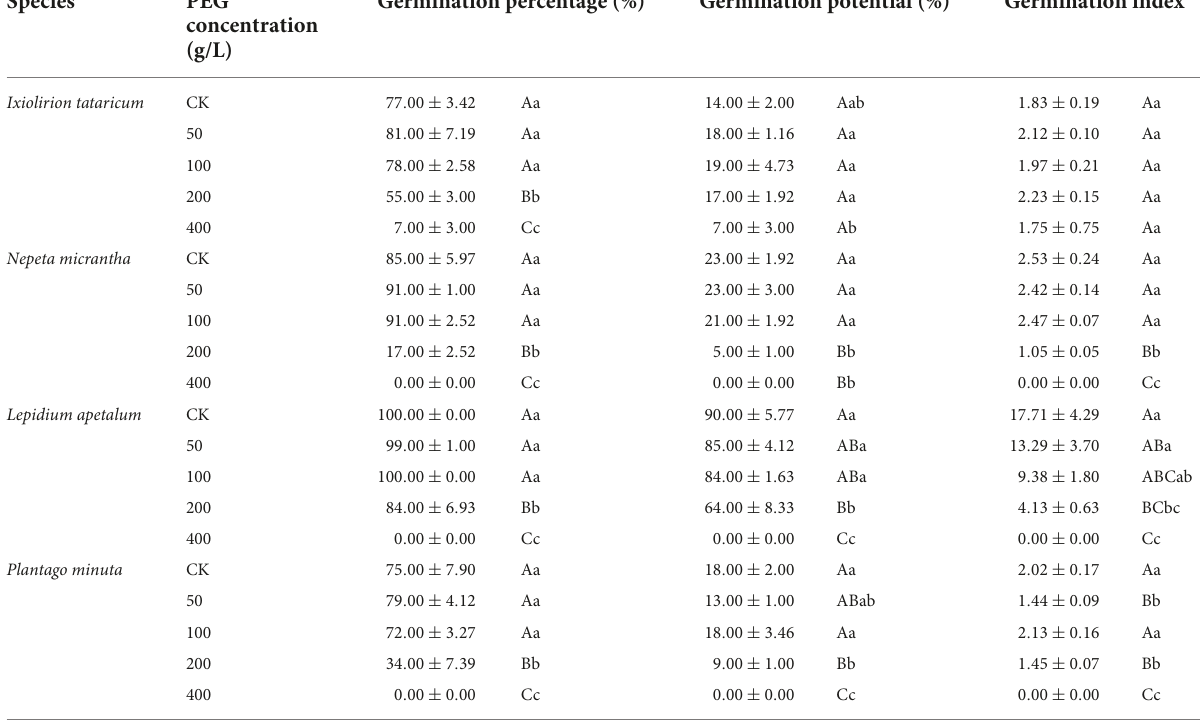
TABLE 2 Effects of different concentrations of PEG on germination percentage, germination potential, and germination index. Species PEG Germination percentage (%) Germination potential (%) Germination concentration (g/L)